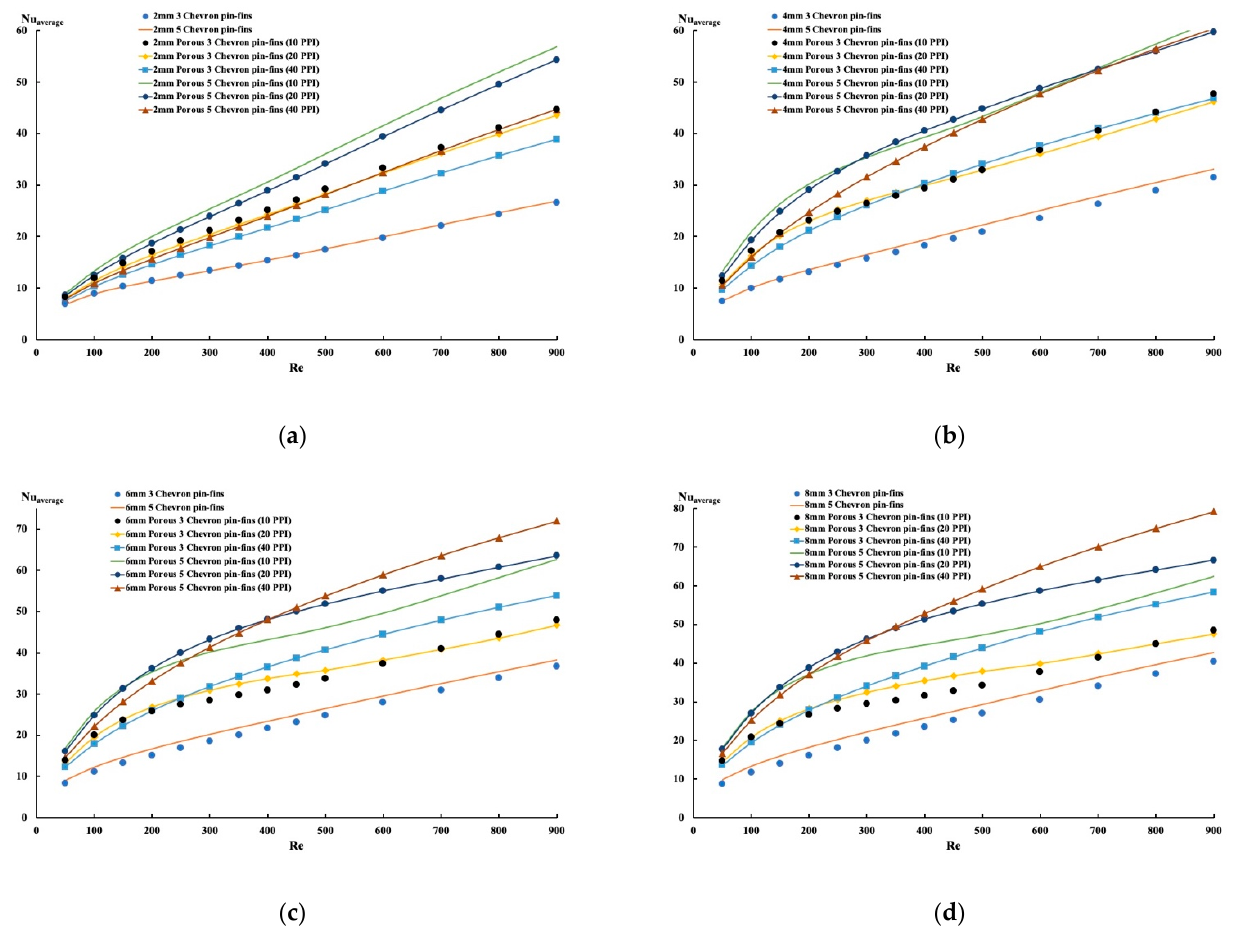
Figure 10. Average Nusselt variation for all cases: ( a ) 2 mm pin-fin height; ( b ) 4 mm pin-fin height; ( c ) 6 mm pin-fin height; ( d ) 8 mm pin-fin height.